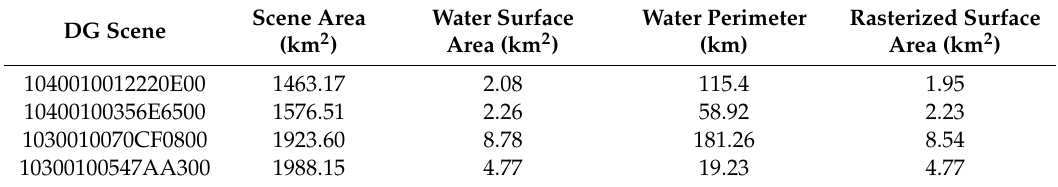
Table 2. In-situ surface water metrics (dates of the images are provided in Table